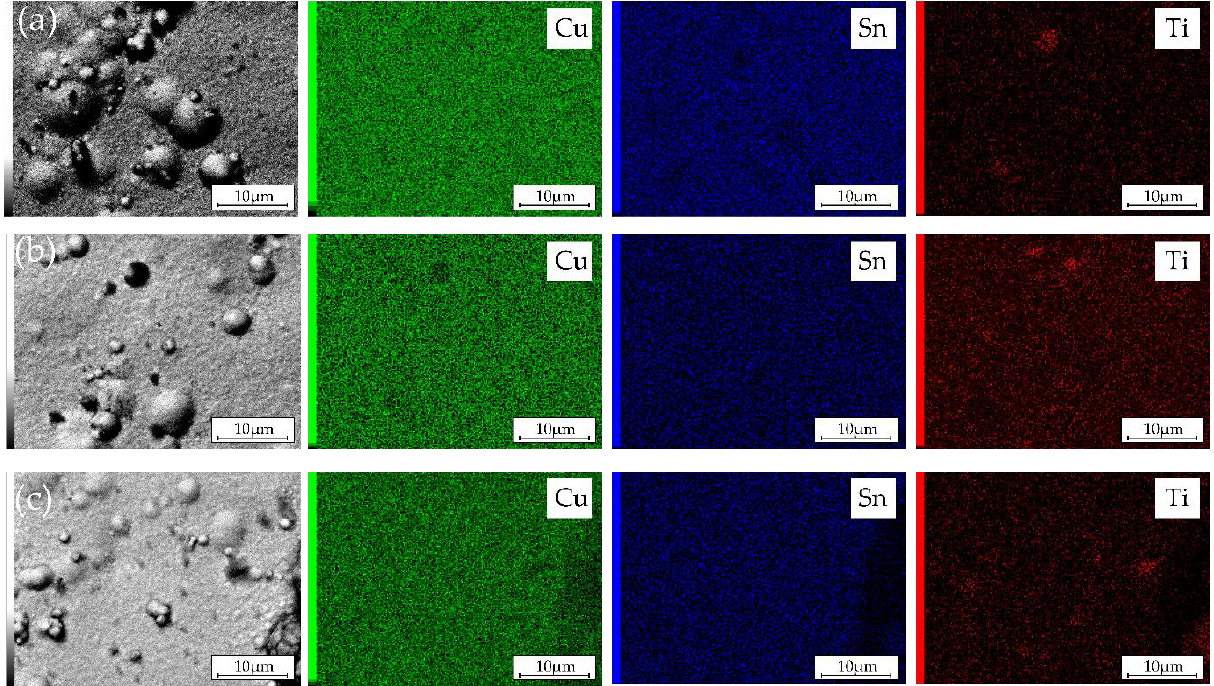
Figure 6. SEM images (to the left) and corresponding EDX elemental maps of Ti-1 ( a ), Ti-5 ( b ), and Ti-10 ( c ) Cu–Sn–TiO 2 composites obtained at −0 .05 V.